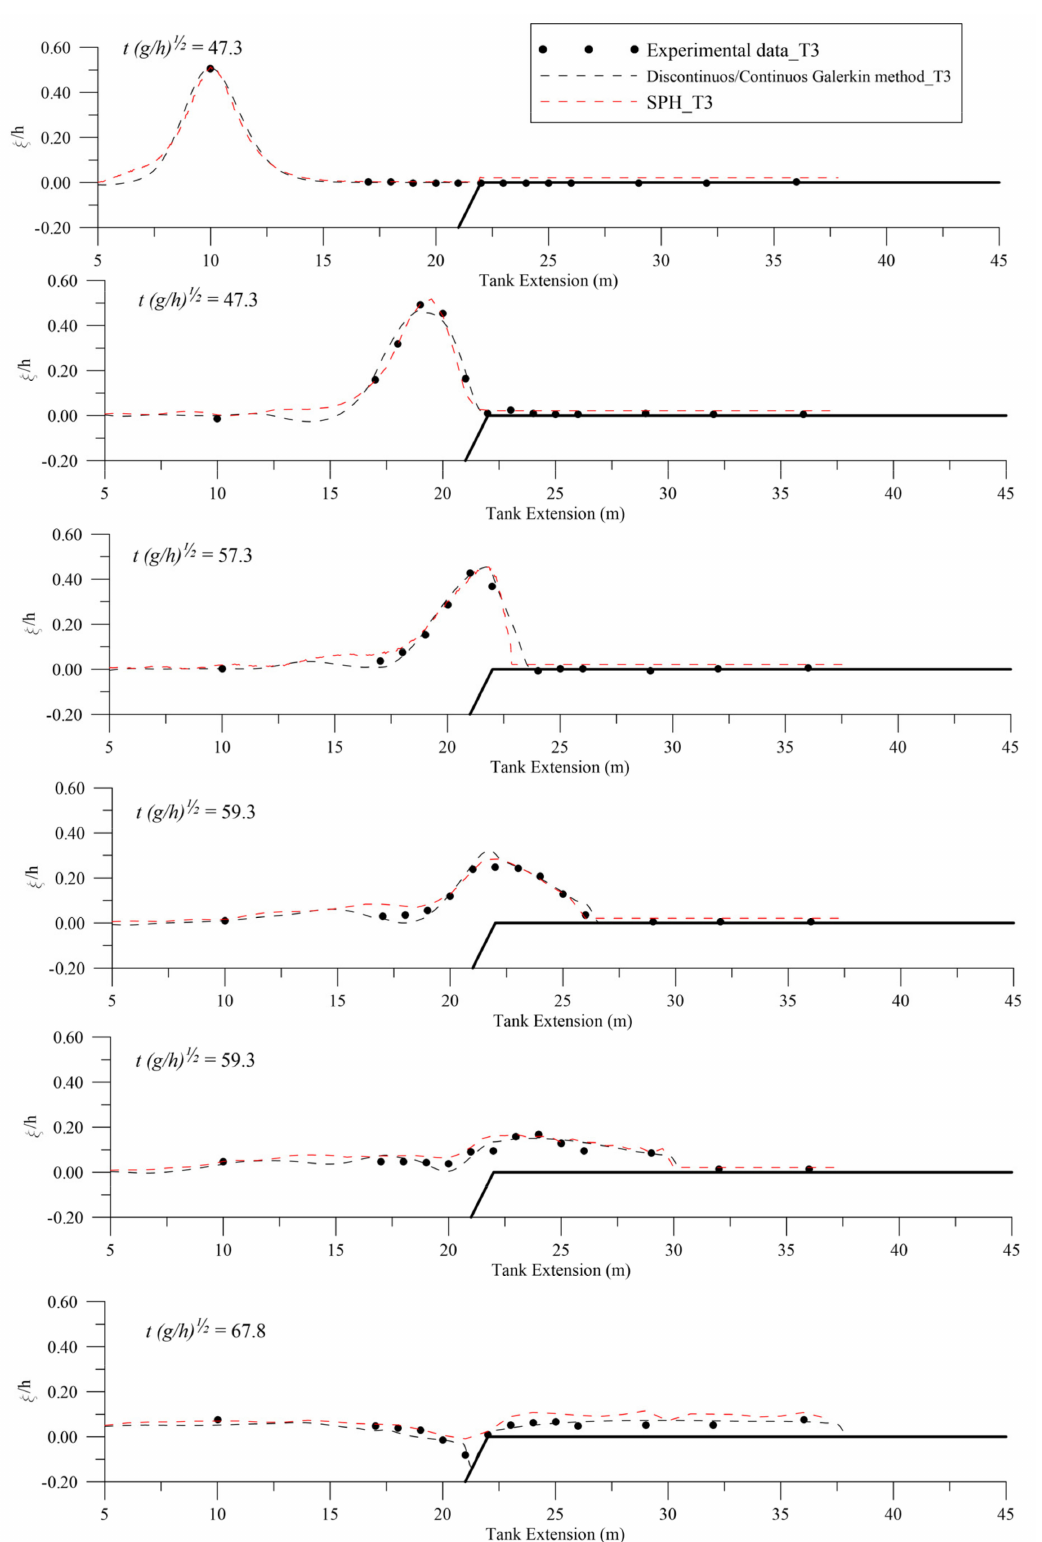
Figure 7. Comparison of experimental and numerical surface profiles of a solitary wave over a fringing reef (T3). Additionally, in T4, both of the numerical approaches reproduce the wave breaking and run-up processes well. In fact, both of the numerical results confirm the